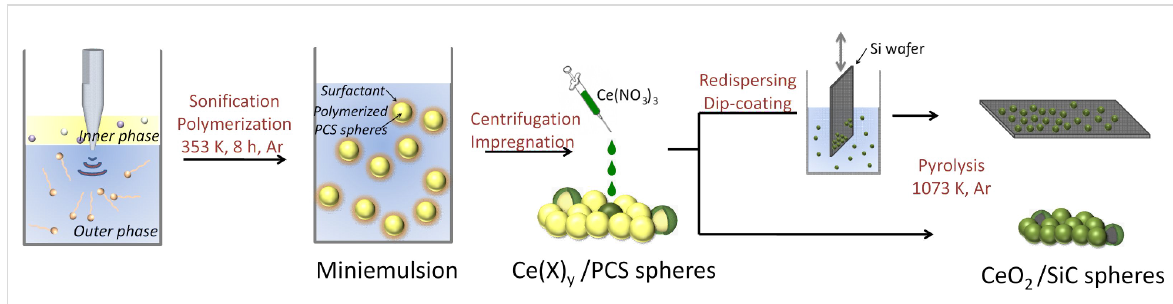
Figure 1: Scheme of the synthesis of CeO 2 /Si(O)C core–shell nanoparticles via miniemulsion technique.